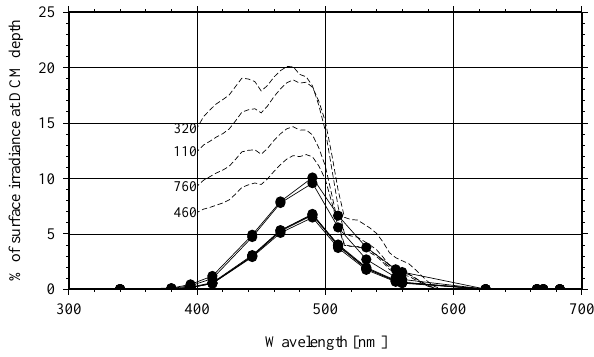
Fig. 12. Percentage of surface irradiance that reaches the depth of the deep chlorophyll maximum (DCM). The percentage is de- termined either from the radiometry profiles (black dots) or from MM01 (dashed curves) fed with the measured vertical Chl a pro- file.